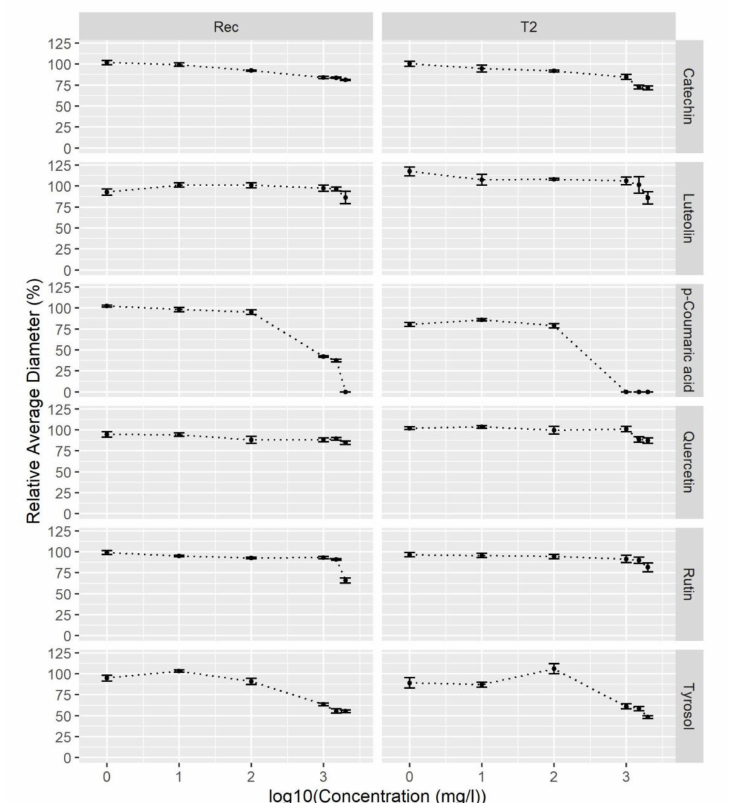
Figure 4. p -Coumaric acid shows the highest inhibitory activity against V. nonalfalfae . The e ffi cacies of six commercial phenolic compounds were expressed as the relative average diameter of fungal colonies (Equation (3) against the log10 of compound concentration). Rec, mild pathotype of V. nonalfalfae , T2, lethal pathotype of V. nonalfalfae . Data present the means ± SE ( n =